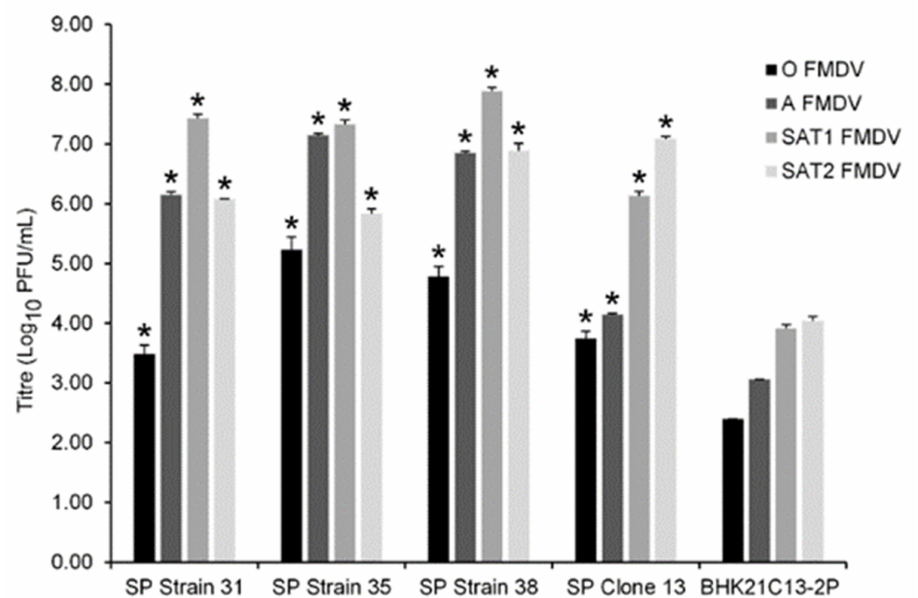
Figure 1. Comparison of FMDV yields produced by suspension BHK-21. Following adaptation to suspension culture, SP Strain 31, SP Strain 35, SP Strain 38 and SP Clone 13 were individually infected (MOI 0.1) with cell culture adapted O/ETH/29/2008, A/ETH/9/2008, SAT1/KEN/80/2010 or SAT2/ETH/65/2009 FMDV strains. BHK21C13-2P were infected alongside and served as a comparative suspension cell line. At 24 hpi, progeny virus in the respective cell culture supernatant was quantified by plaque assay titration. These data are representative of two separate experiments performed in triplicate. Standard deviation bars are shown. Student’s T-test with unequal variance was used to compare respective virus yields between each cell type and BHK21C13-2P; * p <